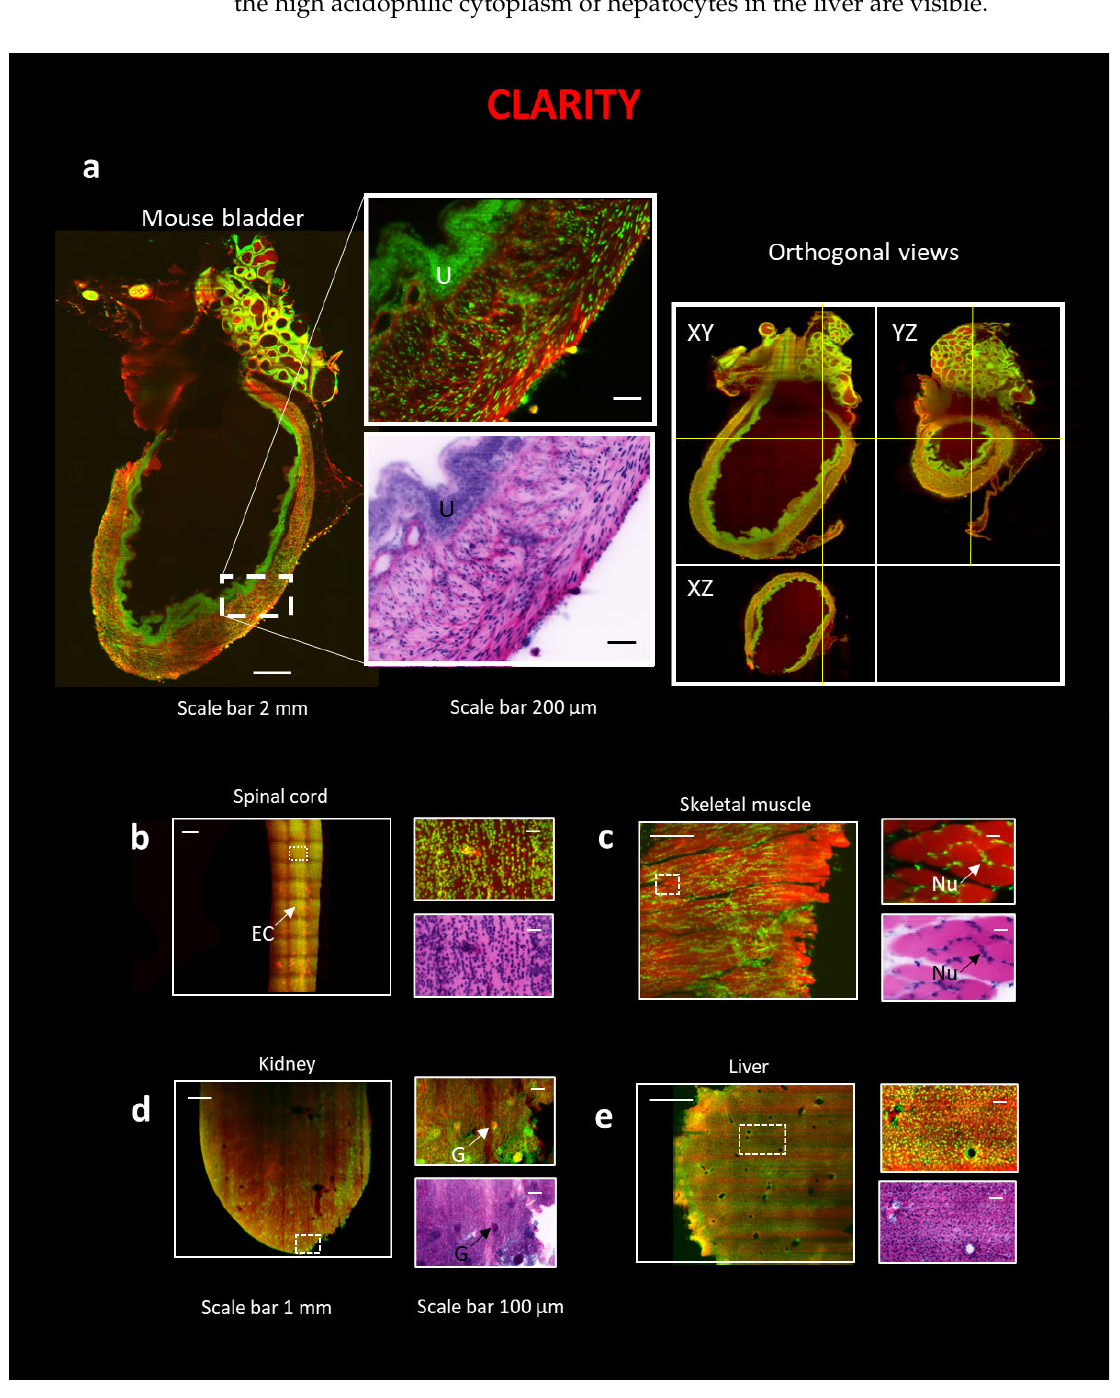
Figure 2. 3D reconstruction of intact organs using the combination of CLARITY technique and LSM. (Left) All organs in the figure are stained with Eosin and SYTOX Blue. (Right) On the top of all images, a zoom ‐ in on a particular region of interest (ROI) is represented, while on the bottom, the same ROI is converted with traditional H&E pseudo ‐ coloration. The following organs are: ( a ) Mouse bladder, scale bar 2 mm, ROI, scale bar 200 μ m. Orthogonal views of the intact mouse bladder. U—